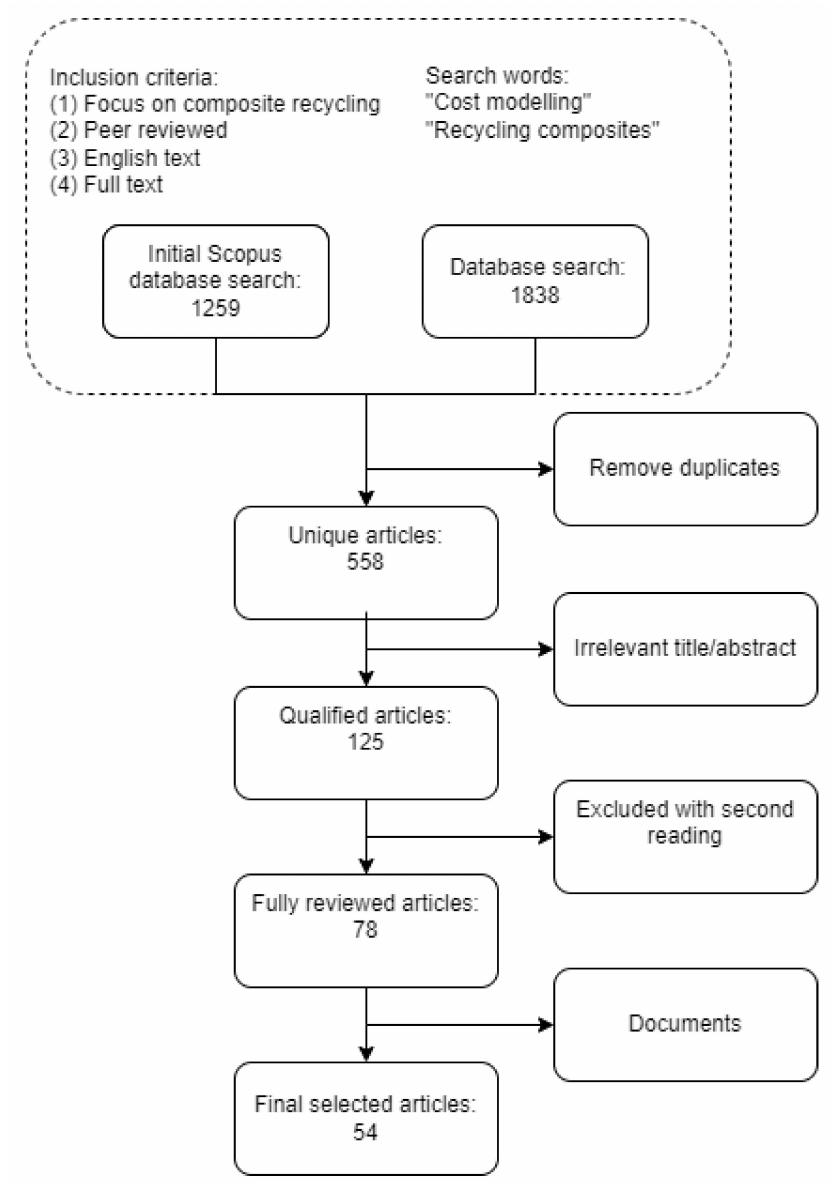
Figure 1. The literature review